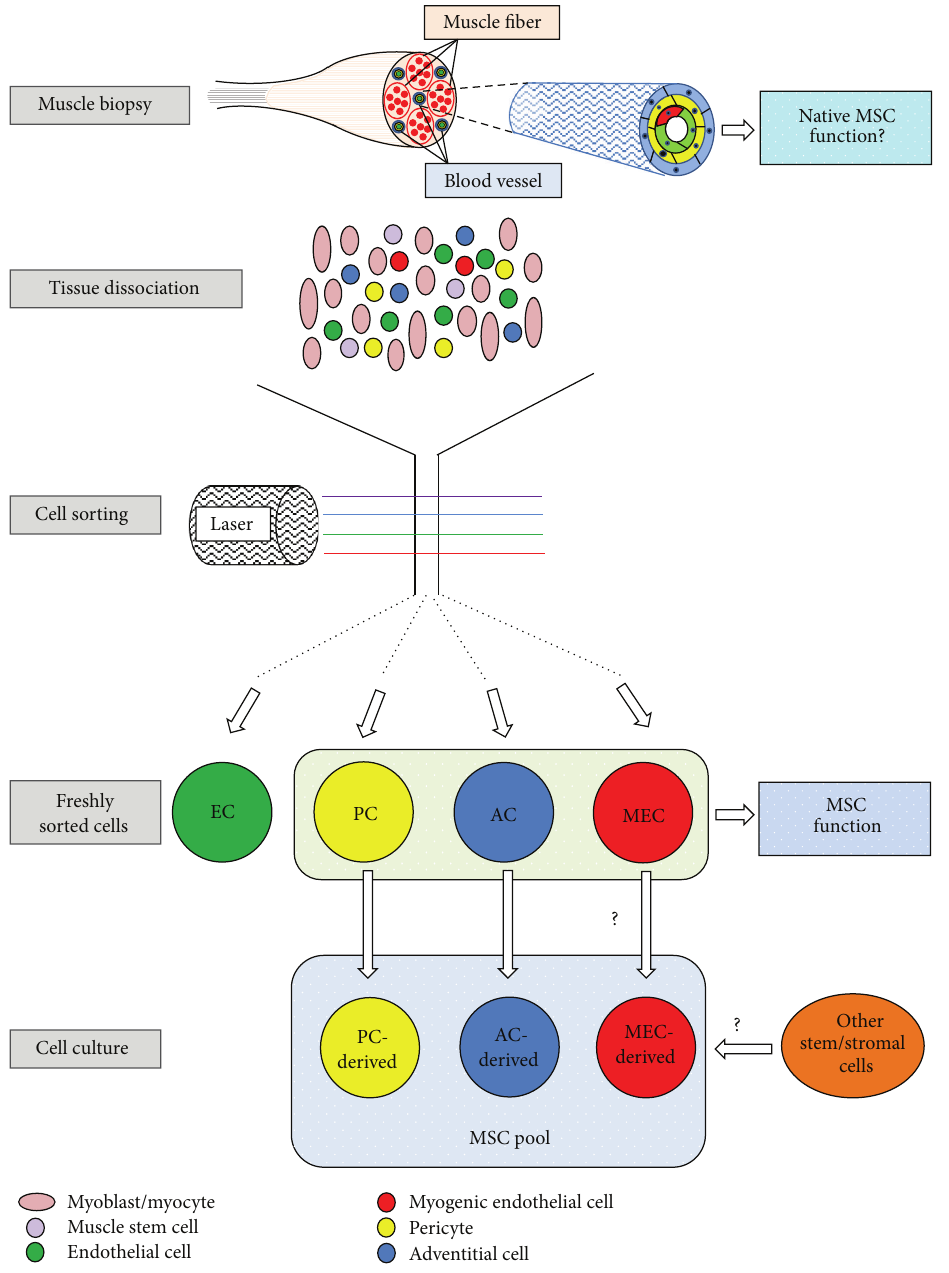
Figure 1: Schematic depiction of hBVSC purification from human skeletal muscle biopsy. Vascular/perivascular cells residing in the blood vessels within the interstitial space of human muscle fibers include endothelial cells (ECs, green), myogenic endothelial cells (MECs, red), pericytes (PCs, yellow), and adventitial cells (ACs, blue). All cells, including immature/mature myocytes and muscle stem cells (i.e., satellite cells), are mechanically and enzymatically dissociated from fresh muscle biopsy. Dissociated cells are subsequently purified to homogeneity by fluorescence-activated cell sorting (FACS). Newly sorted MECs, PCs, and ACs readily exhibit multilineage developmental potentials. Purified PCs, ACs, and possibly MECs give rise to authentic MSCs in long-term culture. However, whether other stem/stromal cells participate in the MSCentityremainstobetested.Moreover,whethernativehBVSCsfunctionastypicalMSCs insitu and/oractivelyrepair/regeneratedefective tissues require further